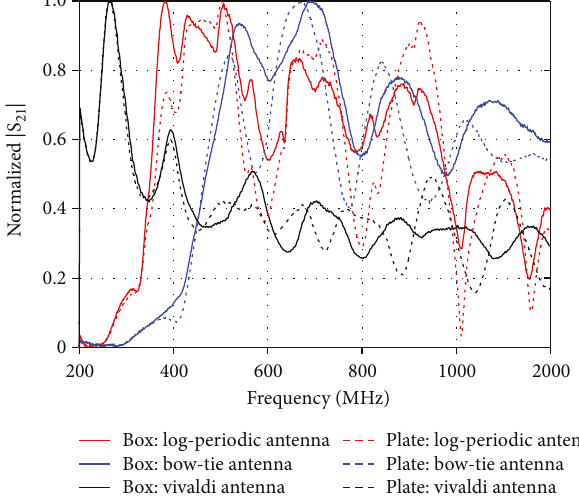
Figure 7: Frequency response obtained from